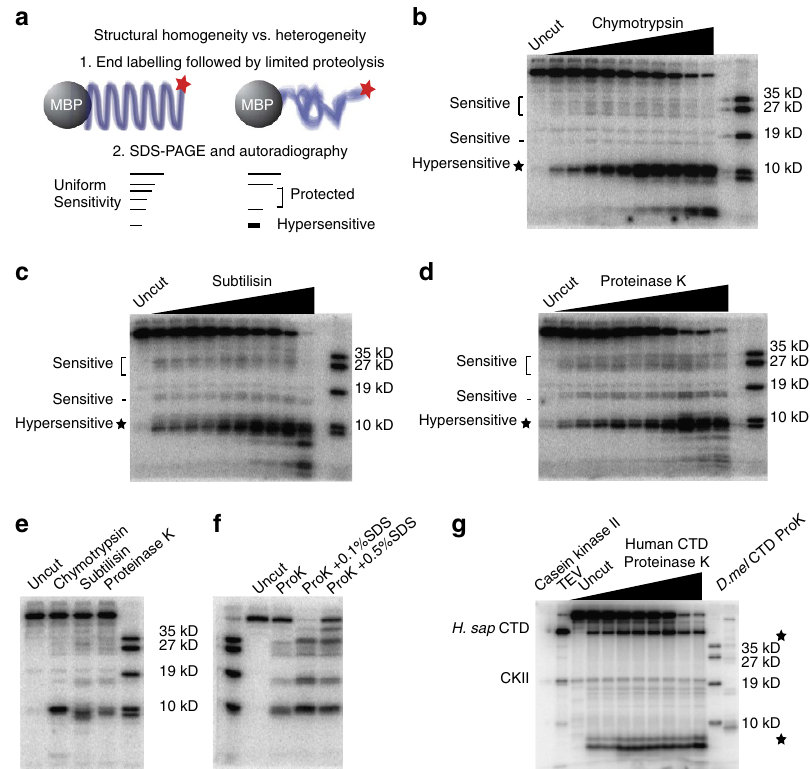
Figure 4 | The CTD is structurally heterogeneous across its length. ( a ) Experimental design: end-labelled MBP- D.mel CTD is subject to limited proteolysis, SDS-PAGE, and autoradiography. A completely unstructured, or alternatively, a structurally repetitive CTD is predicted to generate a uniform pattern of proteolytic fragments. A structurally heterogeneous CTD is predicted to give rise to a non-uniform pattern. ( b ) Limited proteolysis with chymotrypsin generates a non-uniform pattern of CTD fragments, with a hypersensitive site in the distal CTD, a sensitive region in the proximal CTD, and a largely protease insensitive region in the central CTD that is cleaved at only one site. The right most lane contains radiolabelled CTD fusion proteins with the molecular weights designated on the right of the panel. ( c , d ) Limited proteolysis with subtilisin or proteinase K reveal similar sites of sensitivity and protection. ( e ) A direct comparison of proteolytic fragments generated by three proteases shows a similar by not identical pattern of proteolysis. ( f ) Sodium dodecyl sulfate (SDS) alters the relative proteolytic sensitivity of the CTD to proteinase K, enhancing the sensitivity of the CTD at sites that generate bands near 35kD and below 19kD relative to the CTD ladder (0.1% SDS lane). 0.5% SDS renders the globular MBP portion of the fusion protein more susceptible to proteolysis, evidenced by the proteolytic fragment above the 35kD CTD ladder band but below the intact fusion. ( g ) The human CTD is radiolabelled on the final acidic repeat by casein kinase II (CK2) (uncut lane). TEVcleavage to separate the human CTD from the MBP fusion demarcates the point below which protease sensitivity occurs in the CTD portion of the protein (TEV lane). Limited proteolysis with proteinase K reveals a distal hypersensitive site reminiscent of that observed in the Drosophila CTD (compare to D.mel CTD ProK lane), a protease hypersensitive proximal site near MBP and a central region that is largely protease insensitive. Both the human and fly CTDs share distal protease hypersensitivity, proximal sensitivity that is localized to a discrete region in the human CTD, and a more central region of the CTD that is less protease